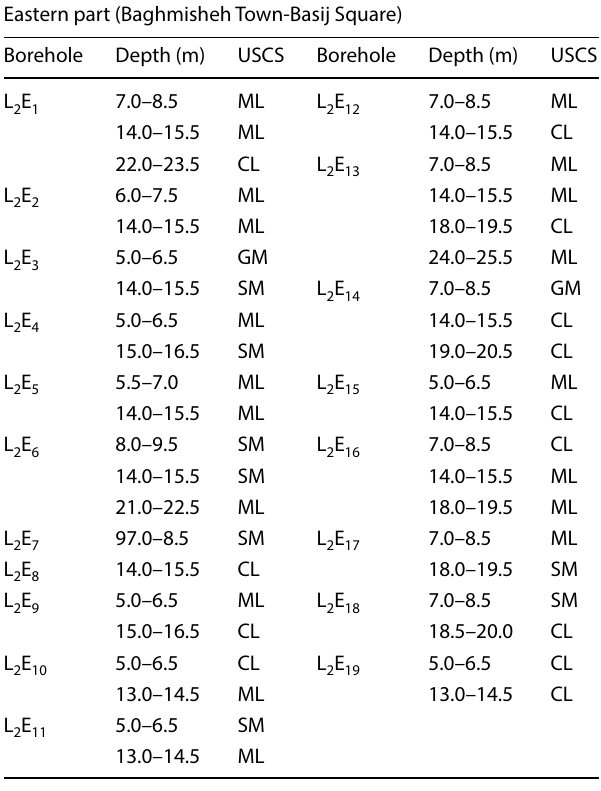
Table 4 Geotechnical specifications of alluvial layers at different depths in the eastern part of TML2 Eastern part (Baghmisheh Town-Basij Square)